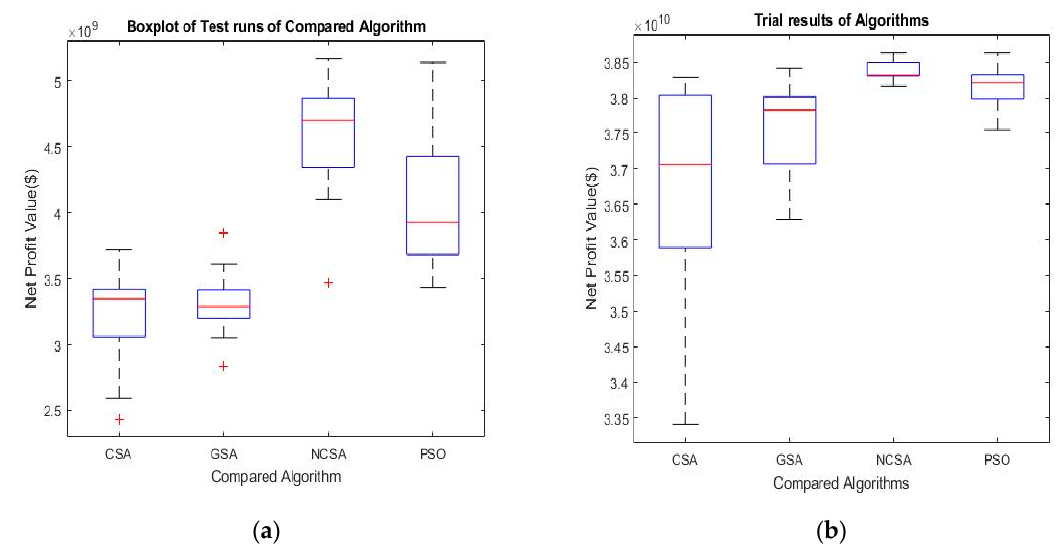
Figure 11. Box plot for PSO, GSA, CSA, and NCSA for ( a ) case study 1 and ( b ) case study 2. Table 6. Statistical data of applied metaheuristic algorithms on well placement optimization for case study 1.